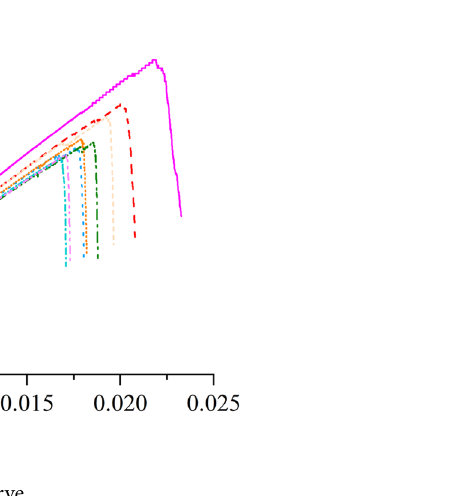
Figure 5. Intact rock stress–strain